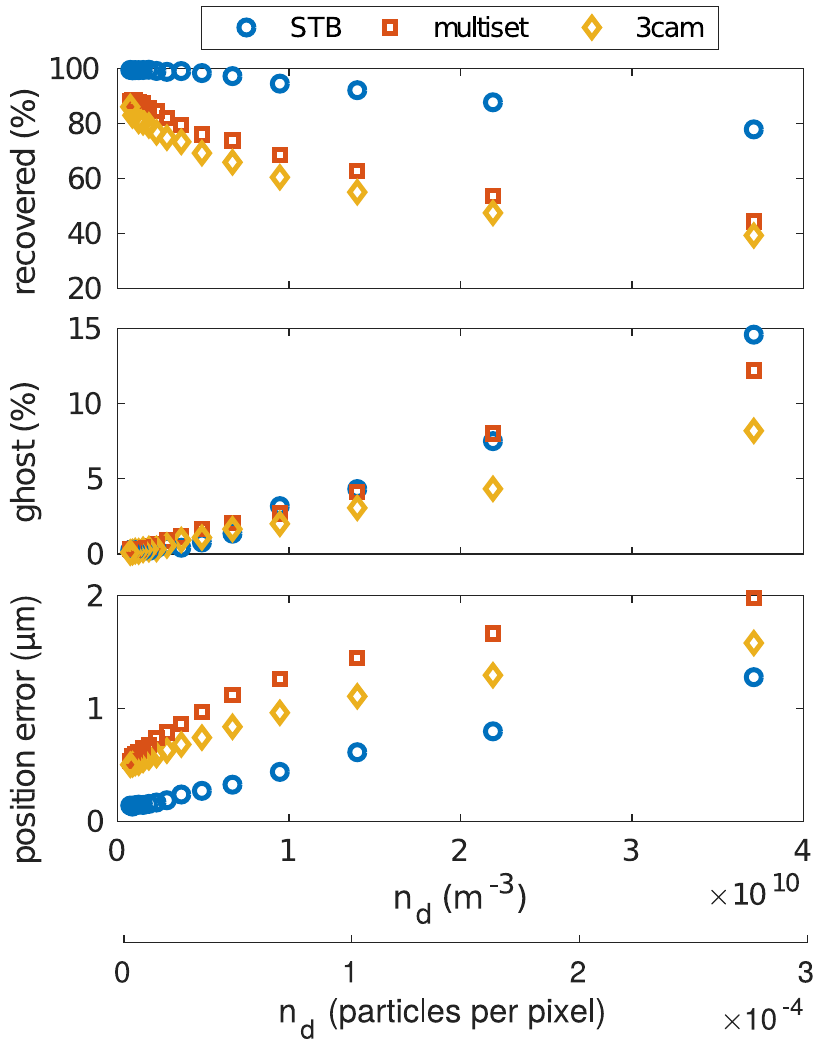
Figure 3. Comparision of the different reconstruction algorithms. While the particle number density n d was varied, the position error, the percentage of the reconstructed particles, and the percentage of ghost particles were determined. The particle number was 500 for all data